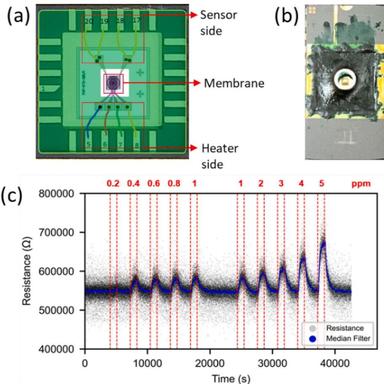
(a) Schematic illustration of wire bond connections; (b) photograph of an encapsulated gas sensor; (c) gas sensing response graph of the encapsulated sensor.